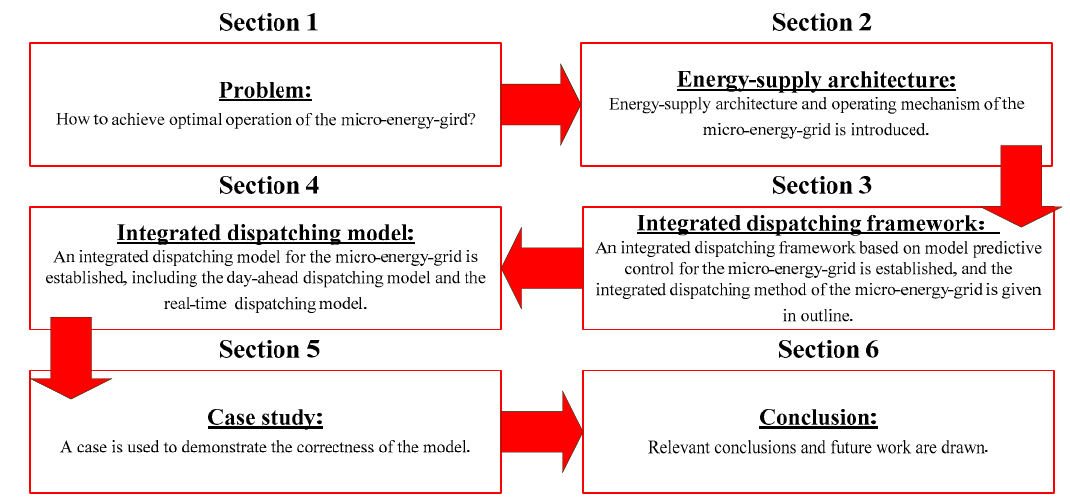
Figure 1. General workflow for the integrated optimal dispatch of the rural micro-energy-grid with multi-energy stream based on model predictive control. multi-energy stream based on model predictive